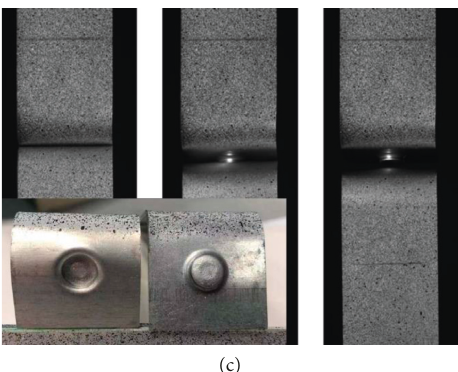
Figure 5: Static coach-peel tests: (a) force-displacement curves, (b) deformation process of SPR joint, and (c) clinched joint at 0.083 × 10 − 3 m/s.